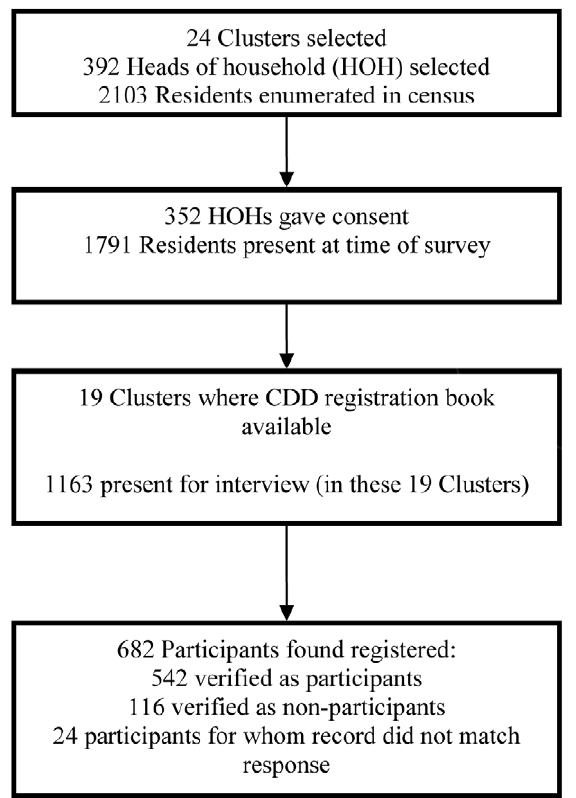
Figure 3. Participation in the survey and verification with CDD registration